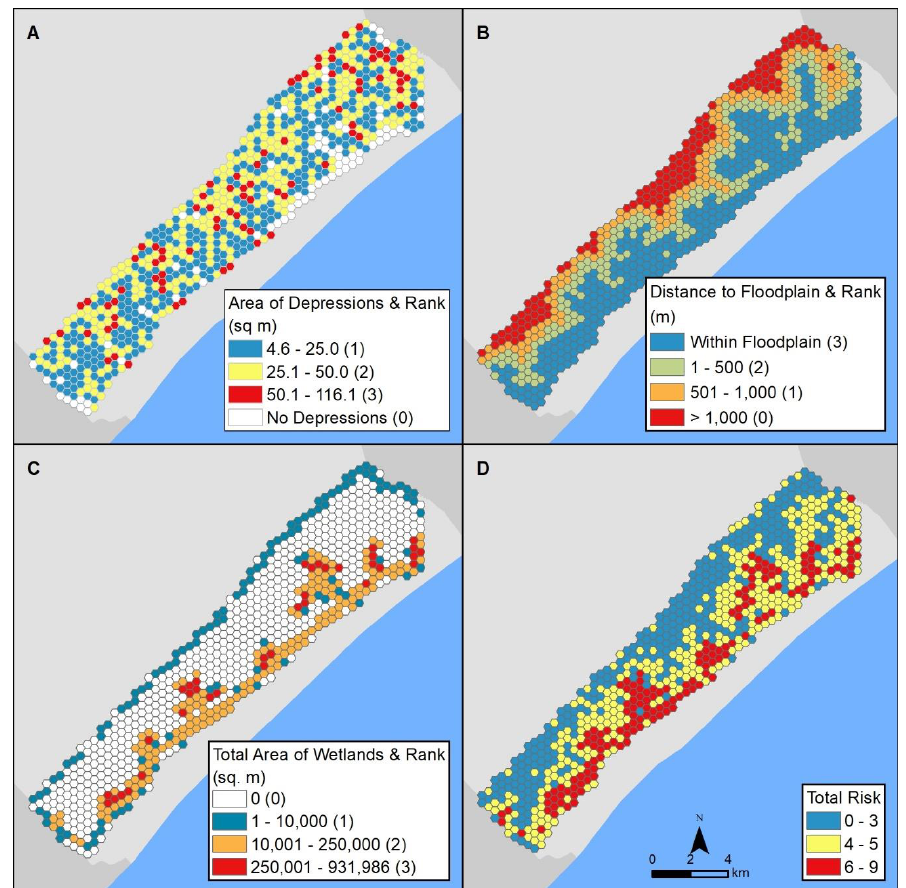
Figure 13. Flood risk in the coastal area is a combination of area of surface depressions ( A ), distance to floodplain ( B ), and area of wetlands ( C ). The total risk is a sum of the rankings for each of these factors ( D ). Remote Sens. 2019 , 11 , x FOR PEER REVIEW